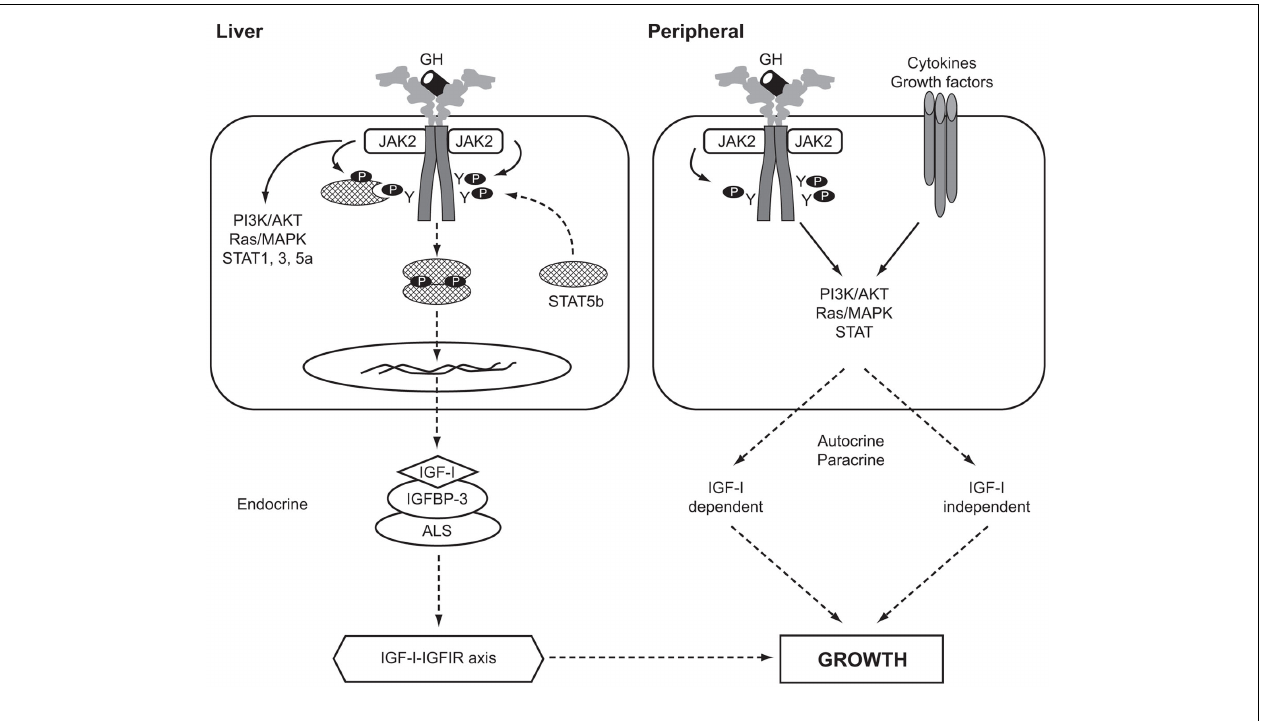
acid-labile subunit; IGFBP-3, IGF-binding protein-3; IGFIR, IGF-I receptor; JAK2, Janus kinase 2; MAPK, mitogen-activated protein kinase; PI3K, phosphatidylinositol 3-kinase; STAT, signal transducer and activator of